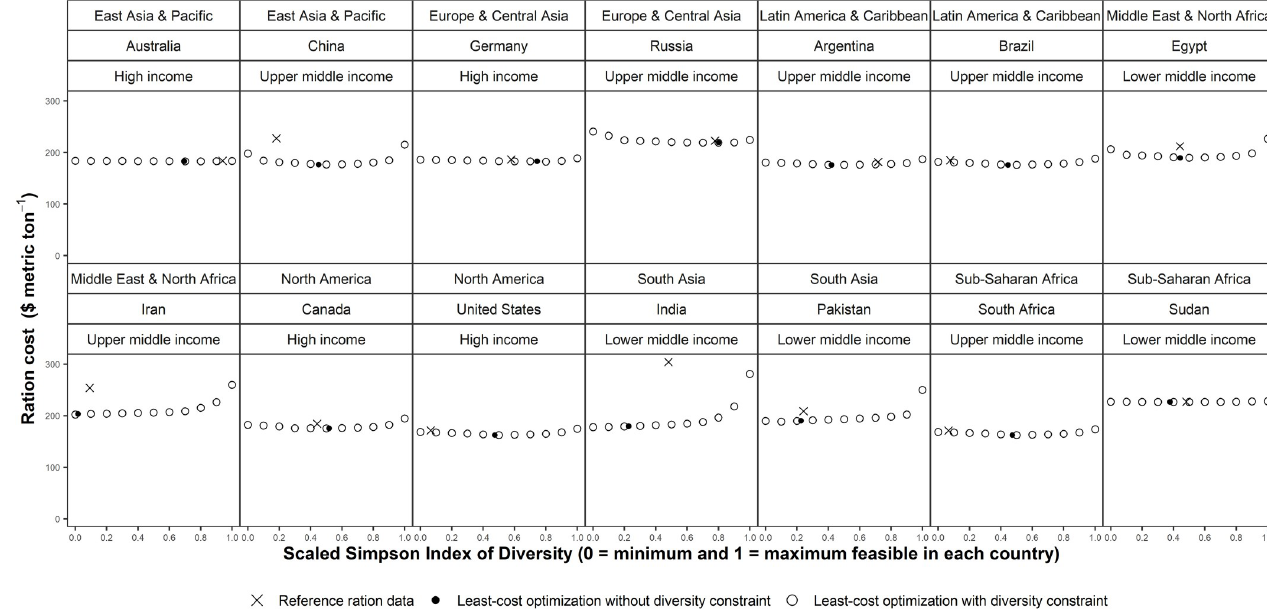
Table 1. As diversity increased from its minimum level to maximum level costs typically declined and then increased again, although the shape of the cost-diversity relationship dif- fered by country. These relationships resulted in different cost-diversity elasticities (Fig 2). The cost-diversity elasticity associated with a one percent increase in diversity around the reference ration level of diversity ranged from − 0.67% to 1.41% (average = − 0.02%). The cost-diversity elasticity in low-income countries ranged from − 0.24% to 0.17% (average = − 0.02%). The cost- diversity elasticity in lower-middle-income countries ranged from − 0.67% to 1.05% (average = − 0.06%). The cost-diversity elasticity in lower-middle-income countries ranged from − 0.38% to 0.20% (average = − 0.02%). The cost-diversity elasticity in high-income countries ranged from − 0.18% to 1.41% (average = 0.03%). A positive cost-diversity elasticity was present in 32% of countries.